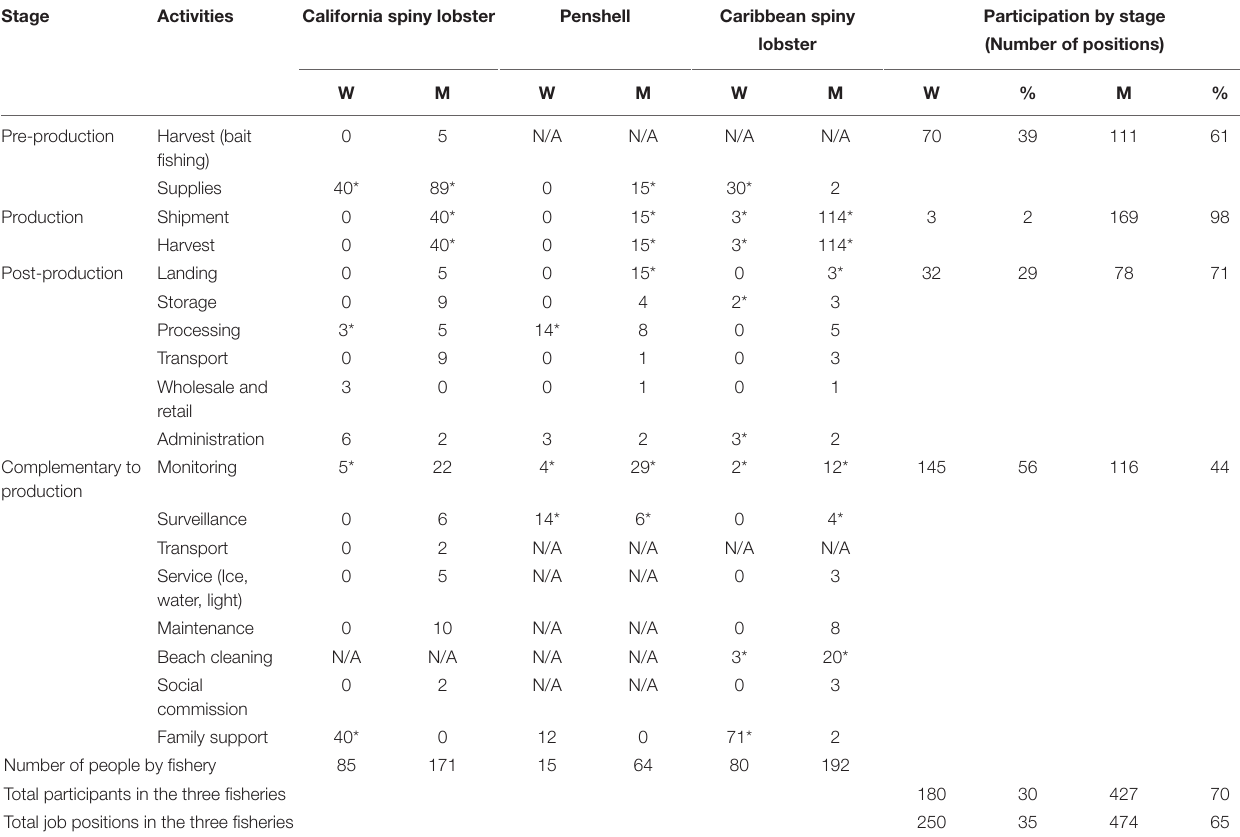
TABLE 4 | Participation at the different steps of the value